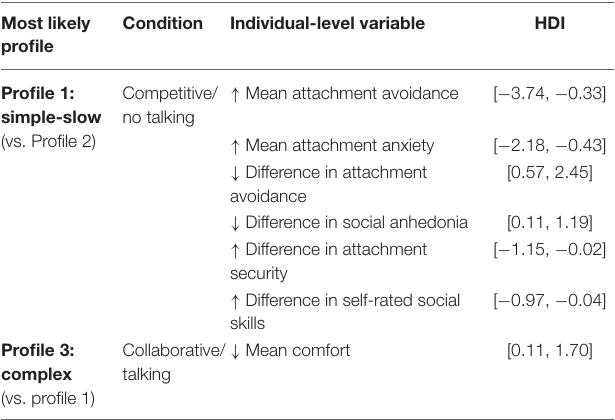
TABLE 6 | Interaction of individual-level variables and condition predicting PL patterns. Most likely